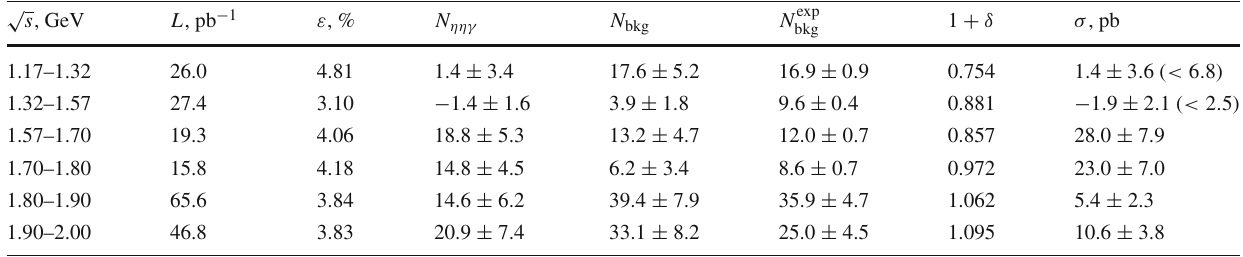
e + e − → ηηγ . The quoted errors are statistical. For the first two energy ranges, the 90% confidence level upper limits on the cross section are given in parentheses. The systematic uncertainty in the cross section is ), √ bkg s < 1 . 32 GeV, 23% for 1 . 32 < 21% for √ s > 1 . 57 GeV for